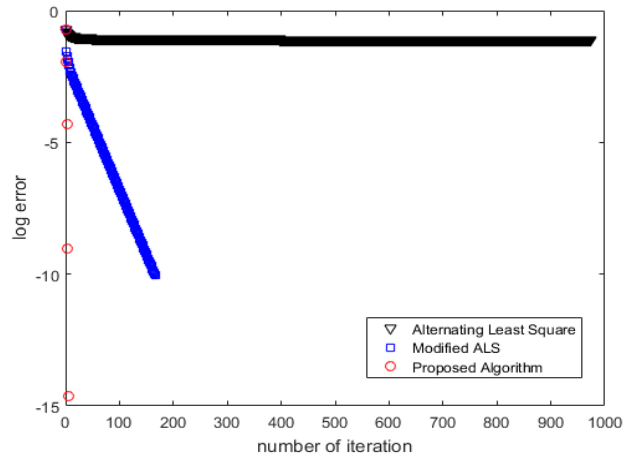
Figure 1. The comparison of the performance: ALS (triangle), modified ALS (square), and proposed algorithm (circle).